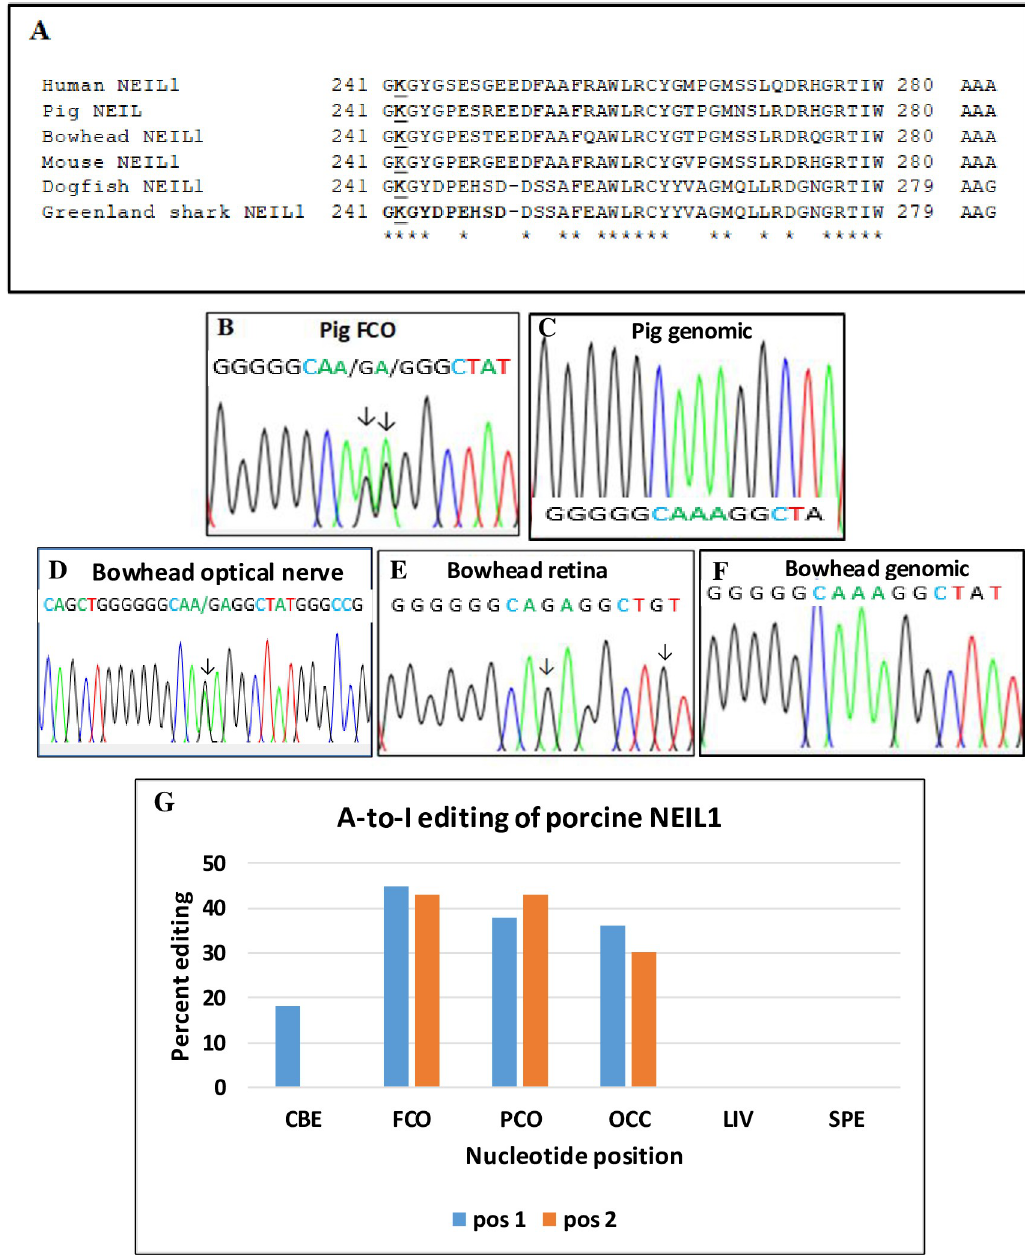
Fig 1. A) NEIL1 exon 6 alignment. Alignment of partial amino acid sequences for NEIL1 from pig, human, bowhead whale, mouse, spiny dogfish and Greenland shark. The following sequences were used in the alignment: Pig NEIL1, GenBank Accession No. NM_001163801; human NEIL1, GenBank Accession No. NM_001553; and mouse NEIL1, GenBank Accession No. NM_001159518. Sequence alignment was performed using the ClustalW program (http://www.genome.jp/tools/clustalw/). The numbers represent the positions of the amino acids in the respective protein sequences. Identical amino acids are indicated by asterisks. The edited amino acid position K242 in exon 6 is marked with bold and underlined letters. The codon sequence for K242 in NEIL1 of the five species is shown at the right. B–D) A-to-I editing of the porcine and bowhead NEIL1 pre-mRNA. Electropherograms showing a partial exon 6 nucleotide sequence of porcine NEIL1 cDNA with two adenosines subjected to A- to-I editing. The edited adenosines are indicated by arrows. E) Editing levels of the amino acid K242 position of the porcine NEIL1 pre-mRNA from various tissues and organs. F) Partial sequence of the bowhead NEIL1 mRNA. G) Histogram showing the quantification of A-to-I editing of adenosines in the K242 codon in porcine NEIL1 mRNA. Abbreviations used: CBE, cerebellum; FCO, frontal cortex; PCO, parietal cortex; OCC, occipital cortex; LIV, liver; SPE, spleen.